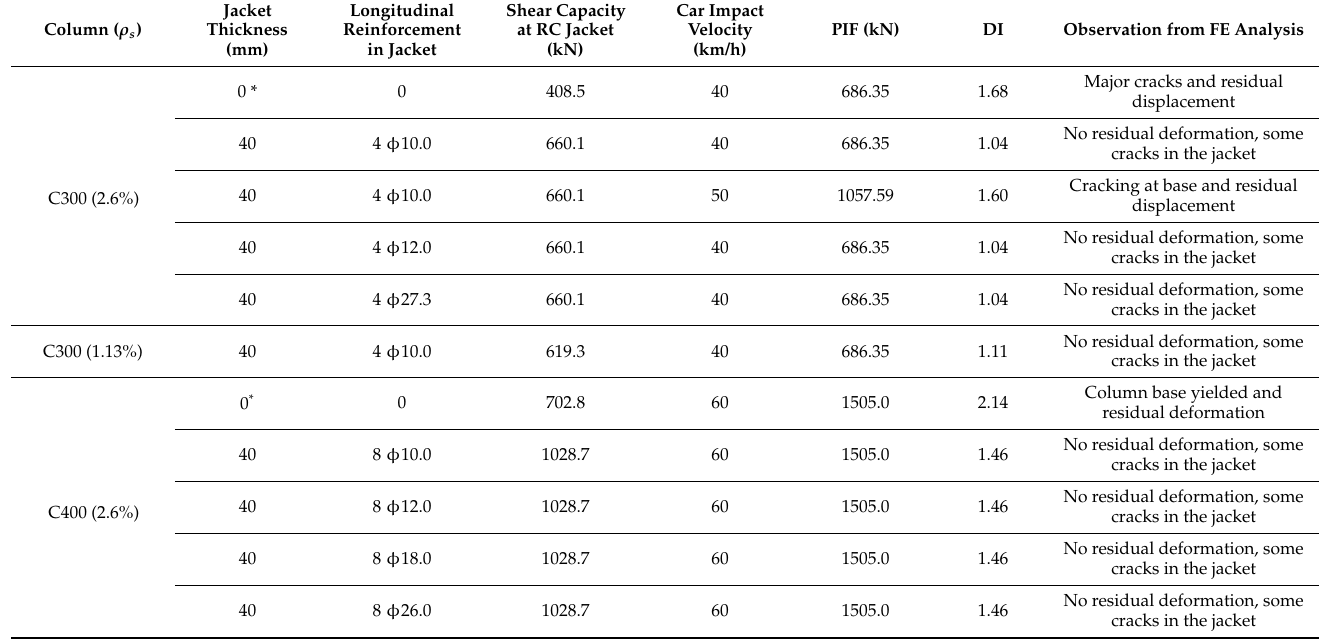
Table 4. Damage index and